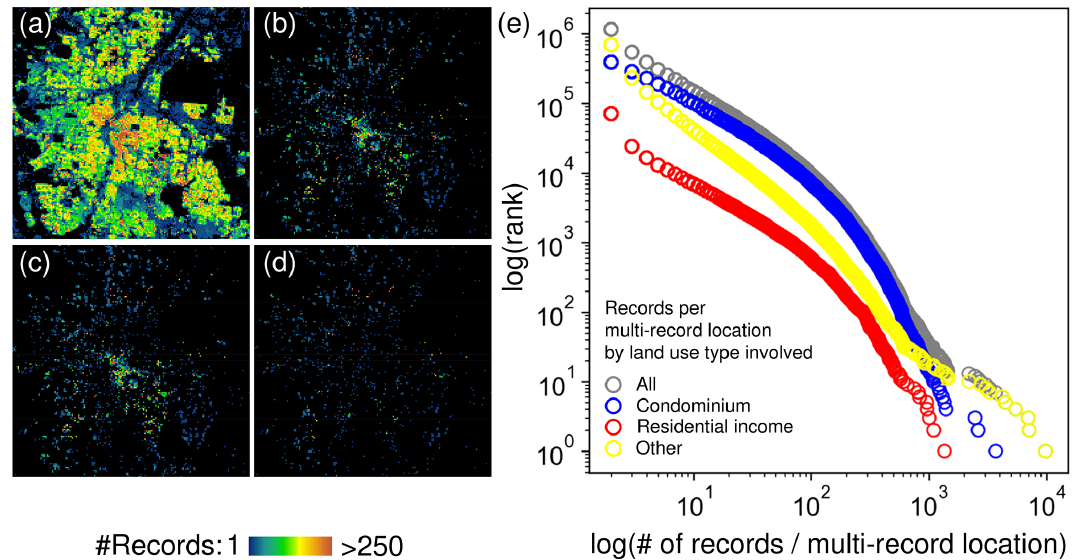
Figure 8. Analysis of multi-record locations. (a) BUPR surface for Denver, Colorado; (b) BUPRs for multi-records only; BUPRs for multi- records (c) without residential-income land use and (d) without residential income or condominiums; (e) rank–size plots of multi-record locations (size = number of multi-records per location) for different land use